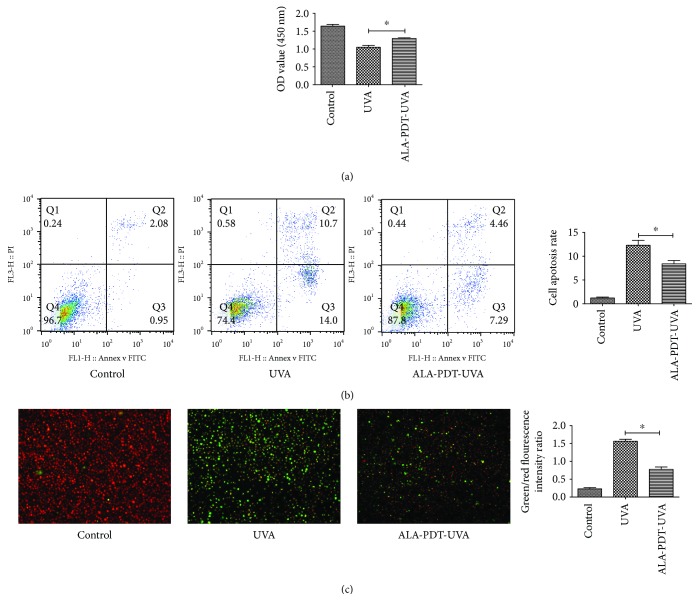
ALA-PDT pretreatment inhibits cytotoxicity and apoptosis of cells irradiated with UVA. Cells were treated with a sublethal dose of ALA-PDT, then these cells were irradiated with 10 J/cm2 of UVA light. (a) The cell viability was detected by CCK-8 assay at 450 nm. (b) The apoptosis of HaCaT cells was measured by using Annexin-V and PI in conjunction with flow cytometry; Annexin-V(+)/PI(−) cells were early-stage apoptotic cells. (c) Early apoptosis was indicated by a decrease in mitochondrial membrane potential. When the fluorescence probe JC-1 underwent a transition from red light to green light, it indicated a decrease in cell membrane potential. This was an indicator of early apoptosis. The fluorescence intensity of the green/red ratio was determined by a fluorescence microplate reader. Data were expressed as mean ± SD, n = 3 for each group, ∗p < 0.05, #p > 0.05.